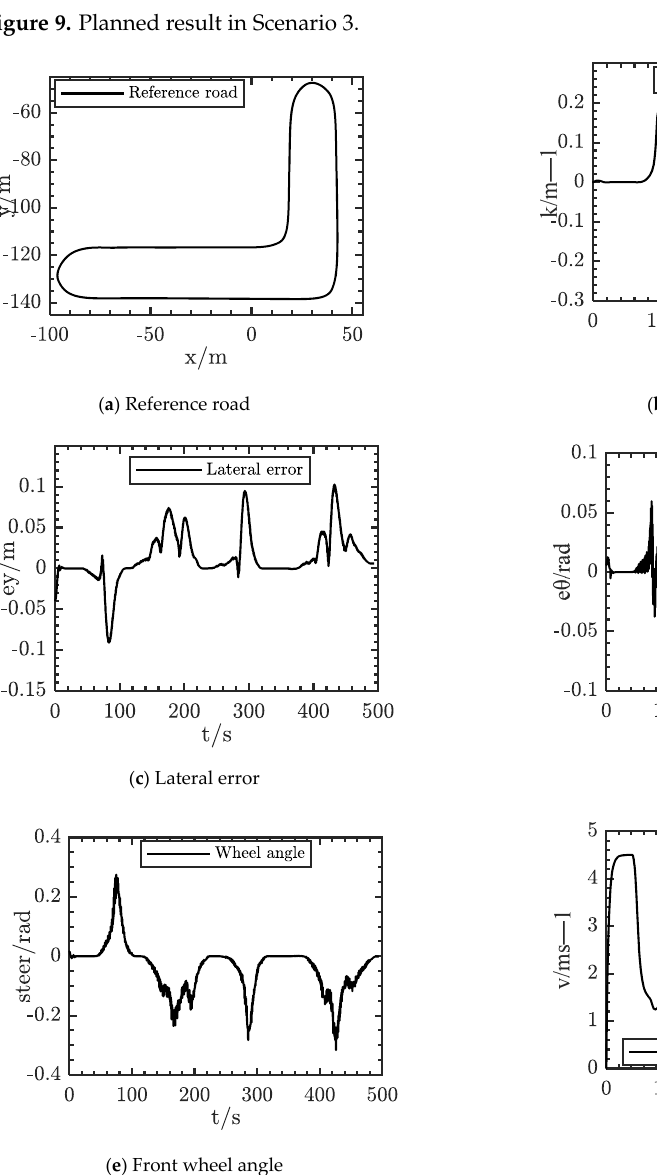
Figure 9. Planned result in Scenario 3.